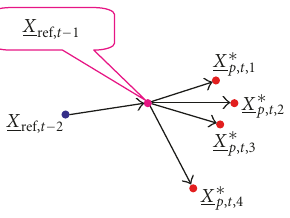
Figure 5: X and X are the reference points at times ref, t − 2 ref, t − 1 t − 2 and t − 1. The vector between these two points forms the displacement vector of the reference point. The red points are four maxima at time t , and hence, they form four displacement vectors. The closest one to the previous displacement vector is